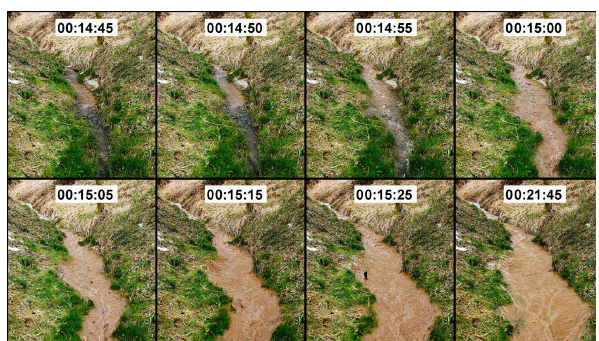
Figure 6. Comparison of the flood wave characteristics measured at the gauging profile and simulated by HEC-RAS. Table 3. Water and sediment budget as measured at the gauging stations (profile C). Wave no.